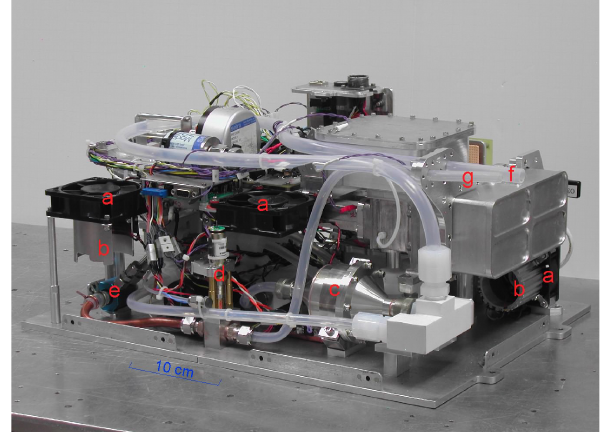
Fig. 2. A photo of the NOAA-2 O 3 instrument without its enclo- sure showing (a) : fans; (b) : heaters; (c) : catalytic scrubber; (d) : flow control valve (V3); (e) : sample flow sensor; (f) : sample line; (g) : ex- haust